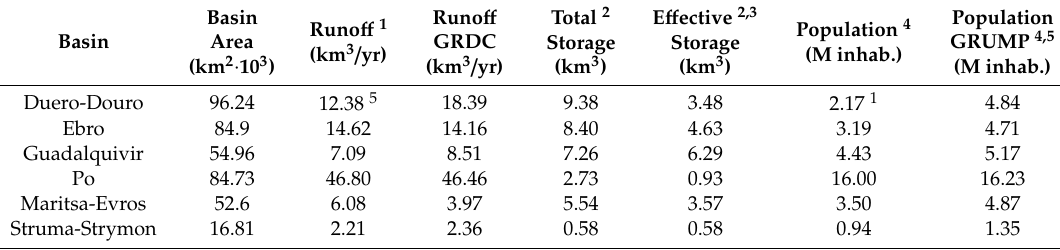
Table 1. Main characteristics of the basins under analysis.